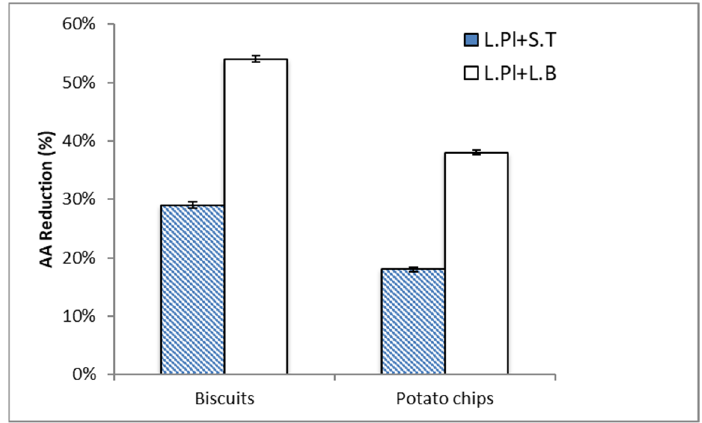
Figure 5. The acrylamide (AA) reduction ability of two formulas of probiotic bacteria: Lactiplantibacillus plantarum ATCC14917 (50%) + Streptococcus thermophilus ATCC19258 (50%) ( L. Pl. + S. T. ) and Lactiplantibacillus plantarum ATCC14917 (50%) + Lactobacillus bulgaricus ATCC11842 (50%) ( L. Pl. + L. B. ), when exposed to biscuits and potato chips under in vitro digestion. Probiotic concentration was 10 8 CFU/mL. Data are the mean of three replicates.